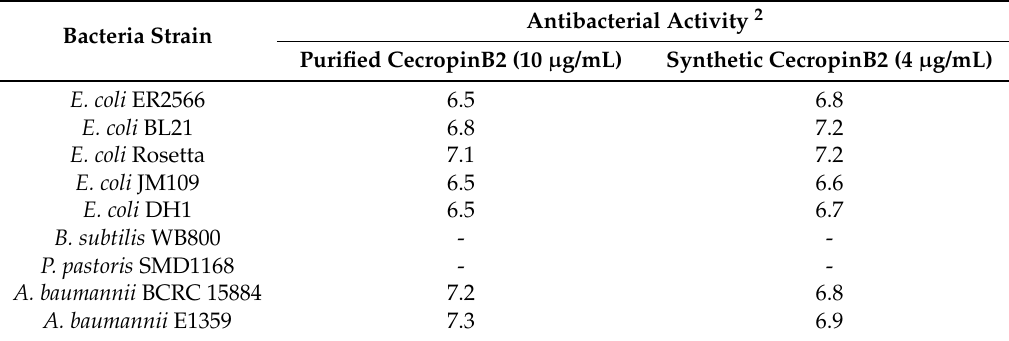
Table 2. Antibacterial spectrum of purified cecropinB2 1 .